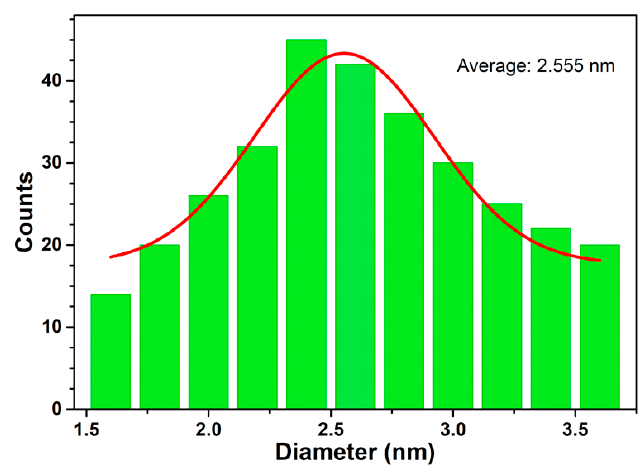
Figure 3. Size distribution of N-CQDs nanoparticles.